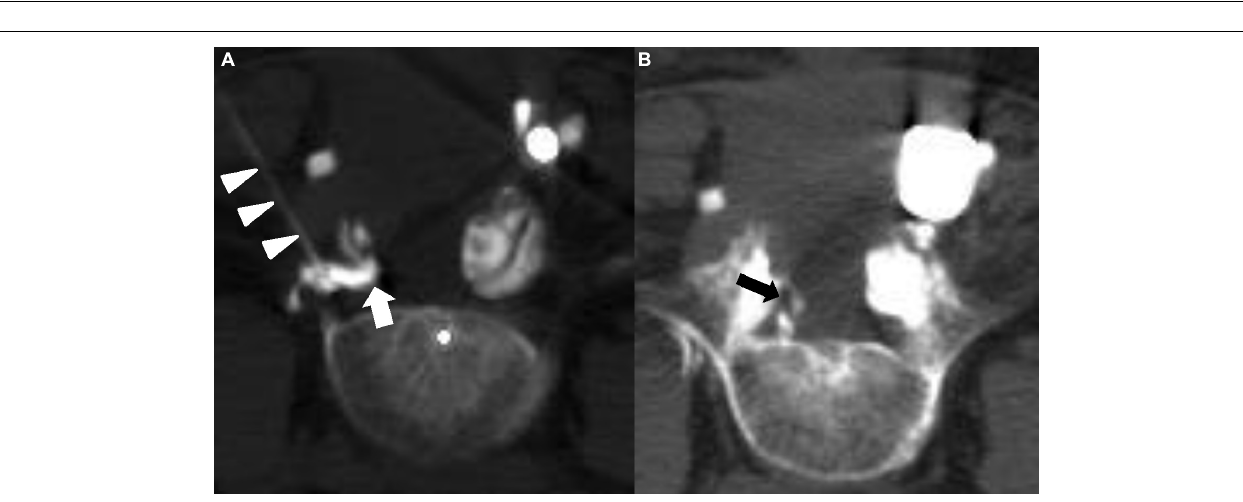
FIGURE 2 | CT-guided transforaminal injection at the level of L5-S1. Axial CT for the extent of contrast spread. (A) Visualization of the needle in the epidural space (arrowheads) and the dye (thick arrow) blocked by the scar. (B) Contrast filling around the right S1 root (thick arrow) at the ventral epidural space.